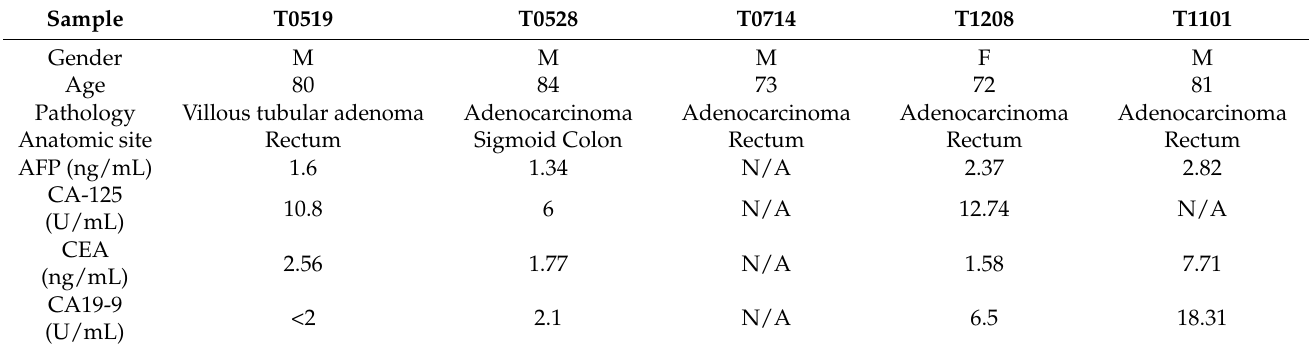
Figure 4. Schematic outline of CRC patient-derived organoid establishment and treatment procedure used to further ascertain bufalin’s activity against C-Kit/Slug signaling. Table 1. Demographic and clinical characteristics of patients undergoing endoscopic